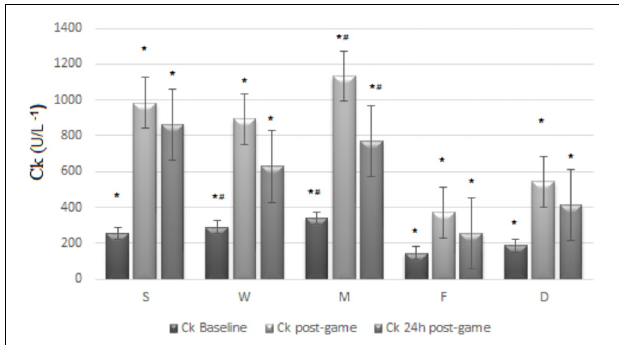
FIGURE 2 | Ck (U/L − 1 ) baseline, post and 24 h post game, by player’s position. *Significant differences from all other moments; # significant differences from Defenders; p < 0.05 for all